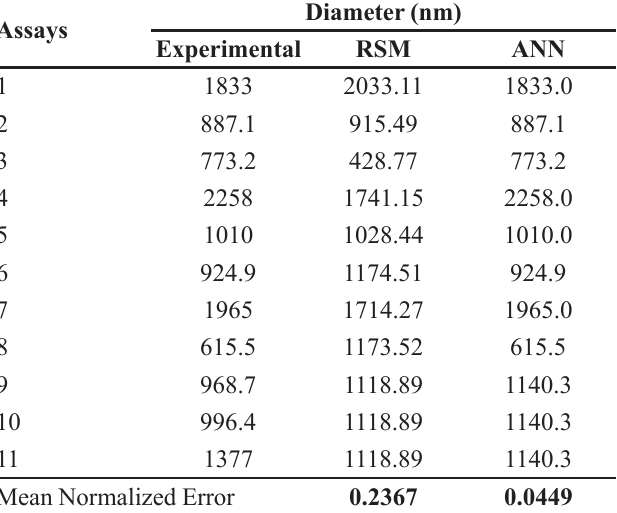
TABLE IV - Comparison between experimental data and predictive models generated by RSM and ANN. Data associated with Equation 4 Assays